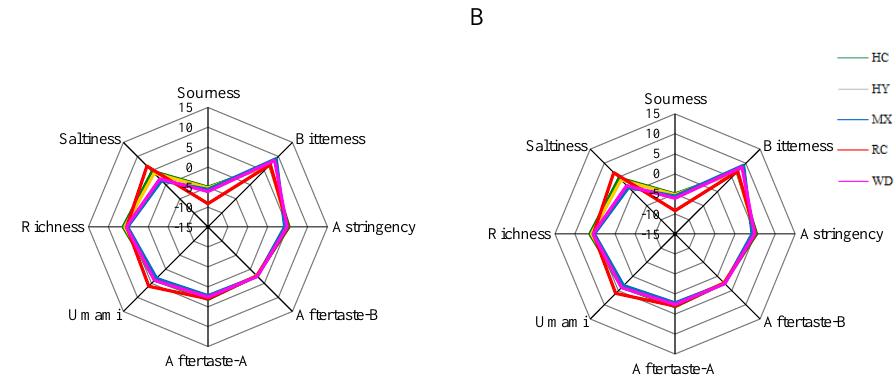
Figure 3. Radar maps for the sensory score of samples based on the electronic tongue ( A ) 40 °C and ( B ) 80 °C.